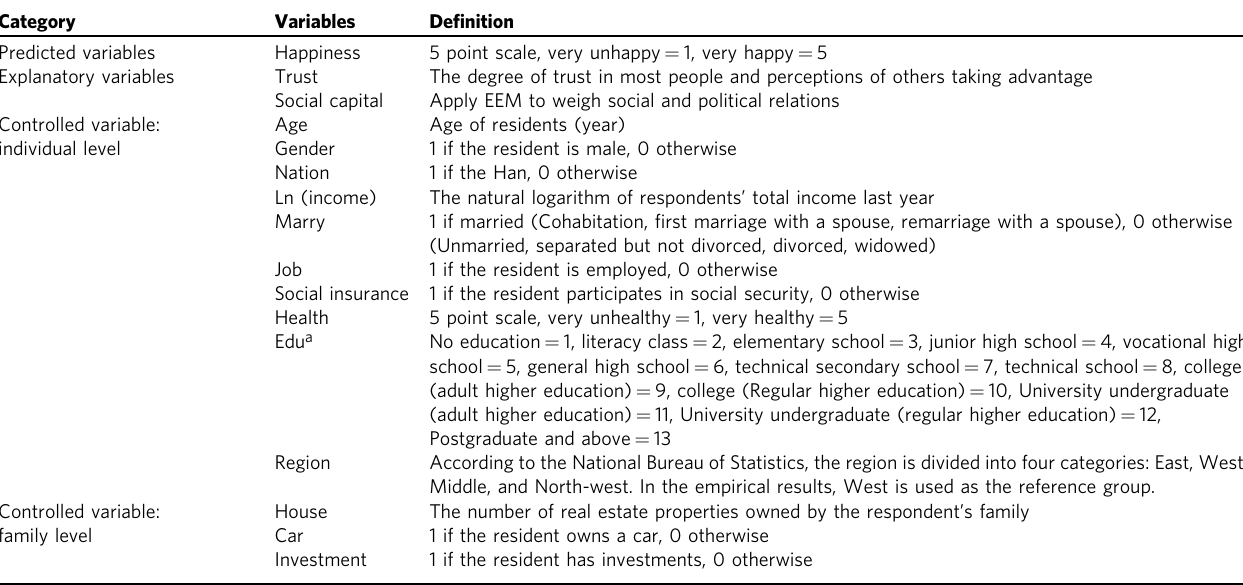
Table 1 Variable de fi